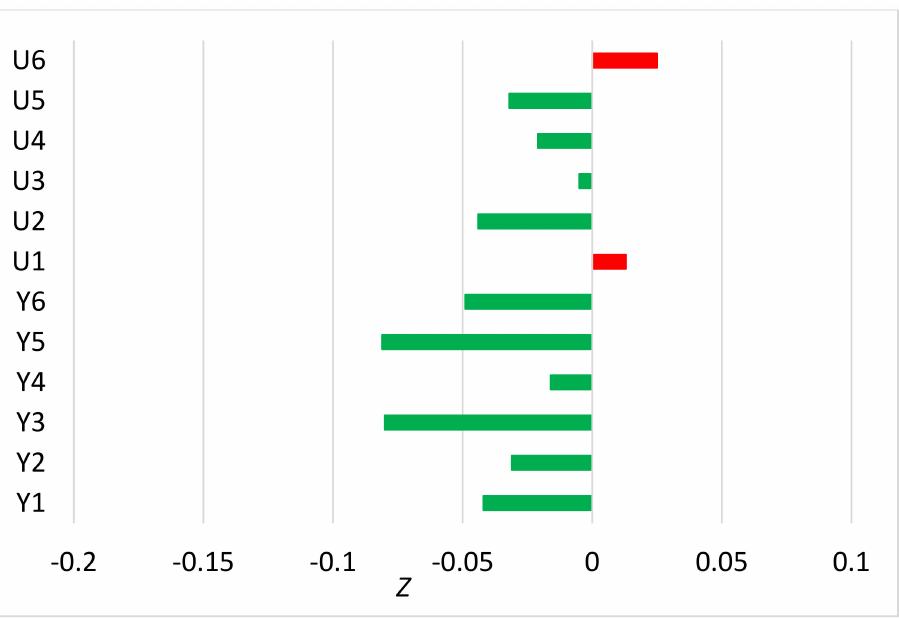
Figure 3. The same as Figure 1, but for the mean absolute trend bias of individual series.